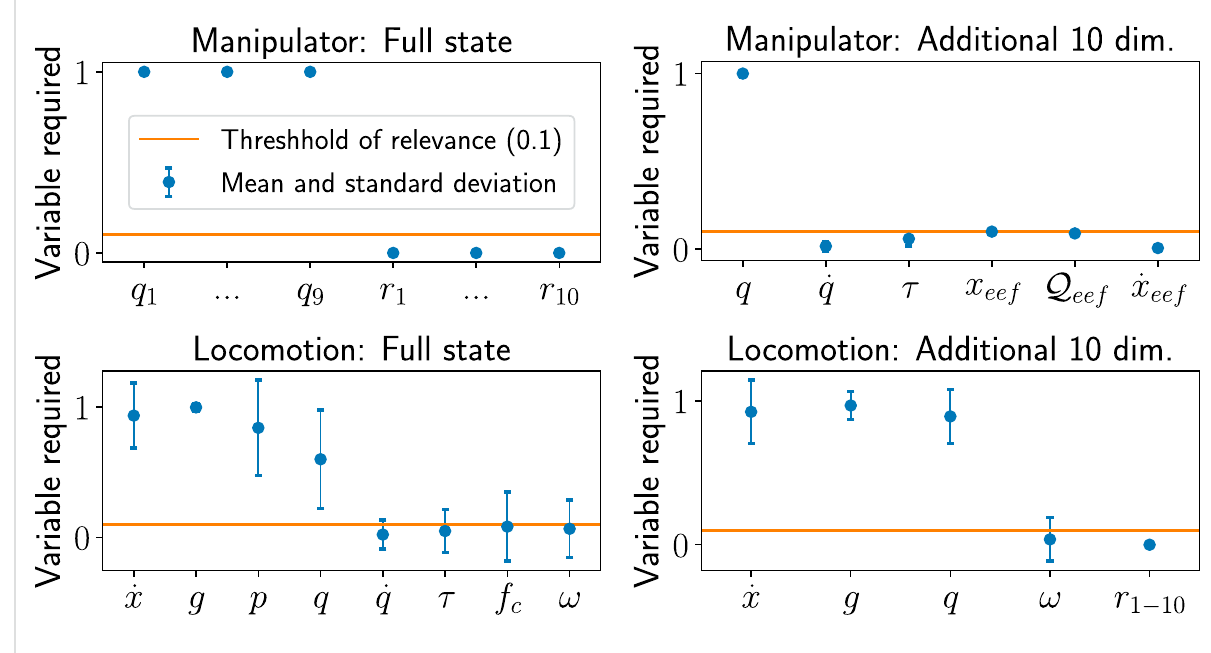
FIGURE 6 Resultsofstateselectionusinglargestate spaceand10additionaldimensionsfor locomotion andmanipulation.Topleft:Full statevariablesfor manipulation, top right: additional 10 values as state variables, bottom left: full state variables for locomotion, bottom right: additional 10 values as state variables for locomotion.